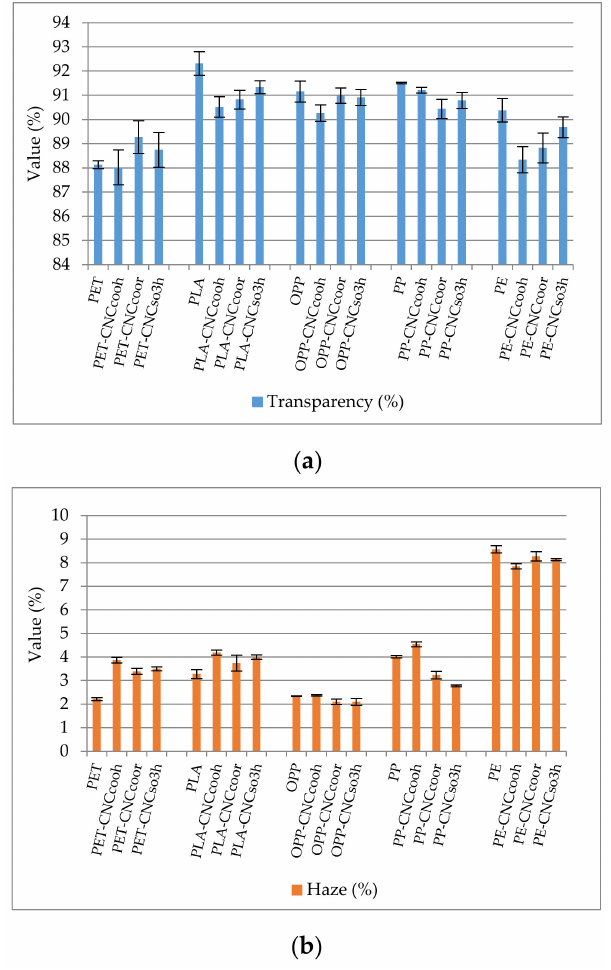
Figure 9. ( a ) Transparency (blu) and ( b ) haze (orange) of uncoated and coated polymers with the three types of CNCs calculated from the mean ± standard deviation ( n =